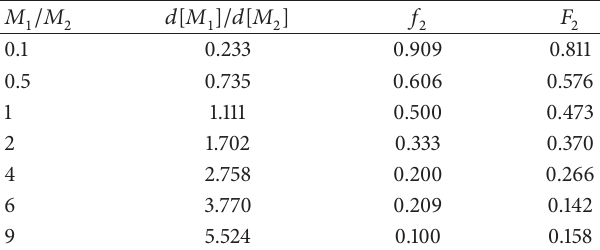
Table 3: Theoretical parameters with values 𝑟 1 = 0.505 and 𝑟 2 = 0.331 of TMEVS/NVP.